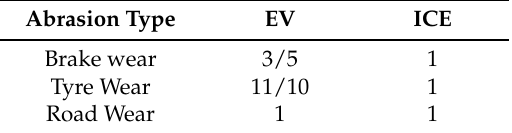
Table 8. Abrasion Coefficients EV and ICE (ICE as reference).